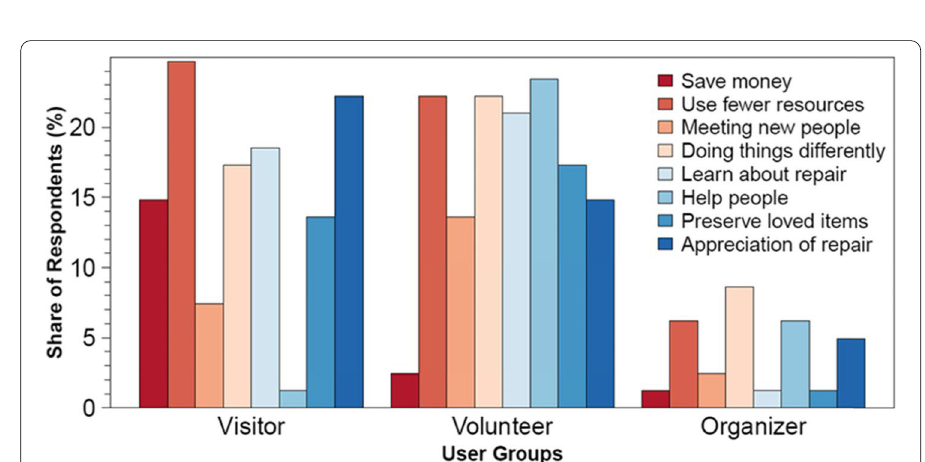
Fig. 3 Motivations for participating in the Repair Cafe by share of respondents and user